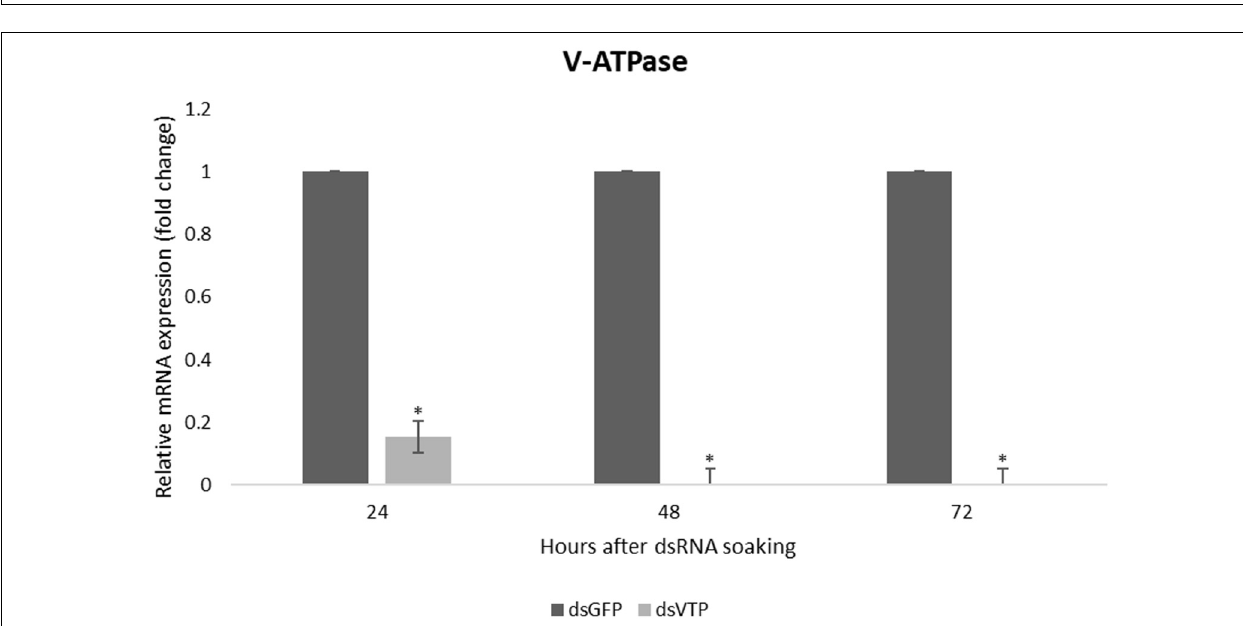
FIGURE 4 | Phylogenetic tree of target gene of silencing, V-ATPase . MEGA X was used to construct the phylogenetic tree with Neighbor-Joining method. Anastrepha fraterculus sequence from transcriptome was marked with a red triangle. All accession numbers are shown in Supplementary Table S4 .